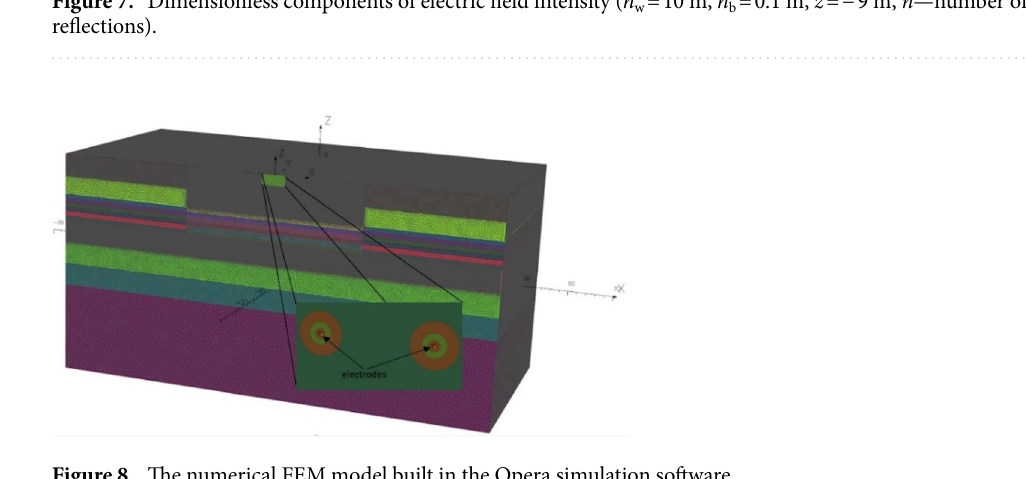
Figure 8. The numerical FEM model built in the Opera simulation